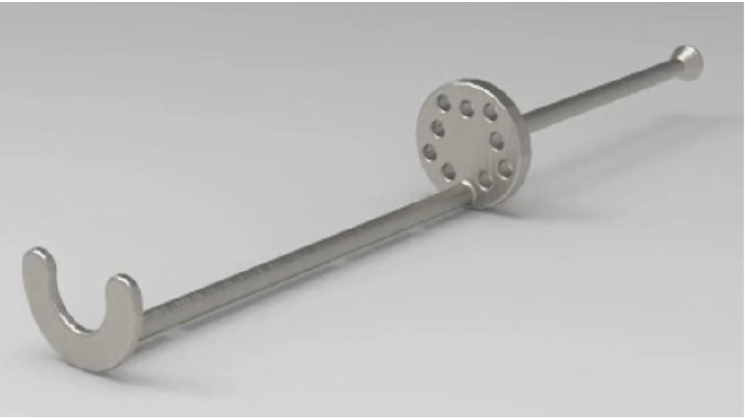
Figure 1. The Sticky Bone Preparation Device (SBPD ® ).